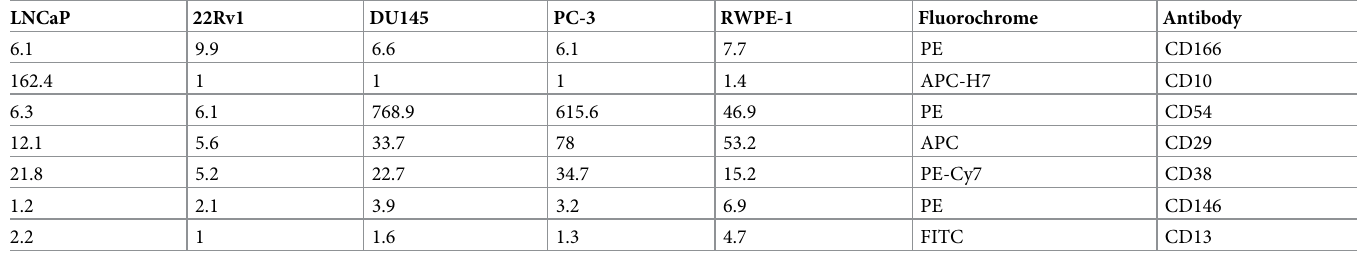
Table 2. Mean fluorescence intensity (MFI) ratio for prostate cancer cell lines. The MFI of the stained cells was compared to the MFI of the unstained control.